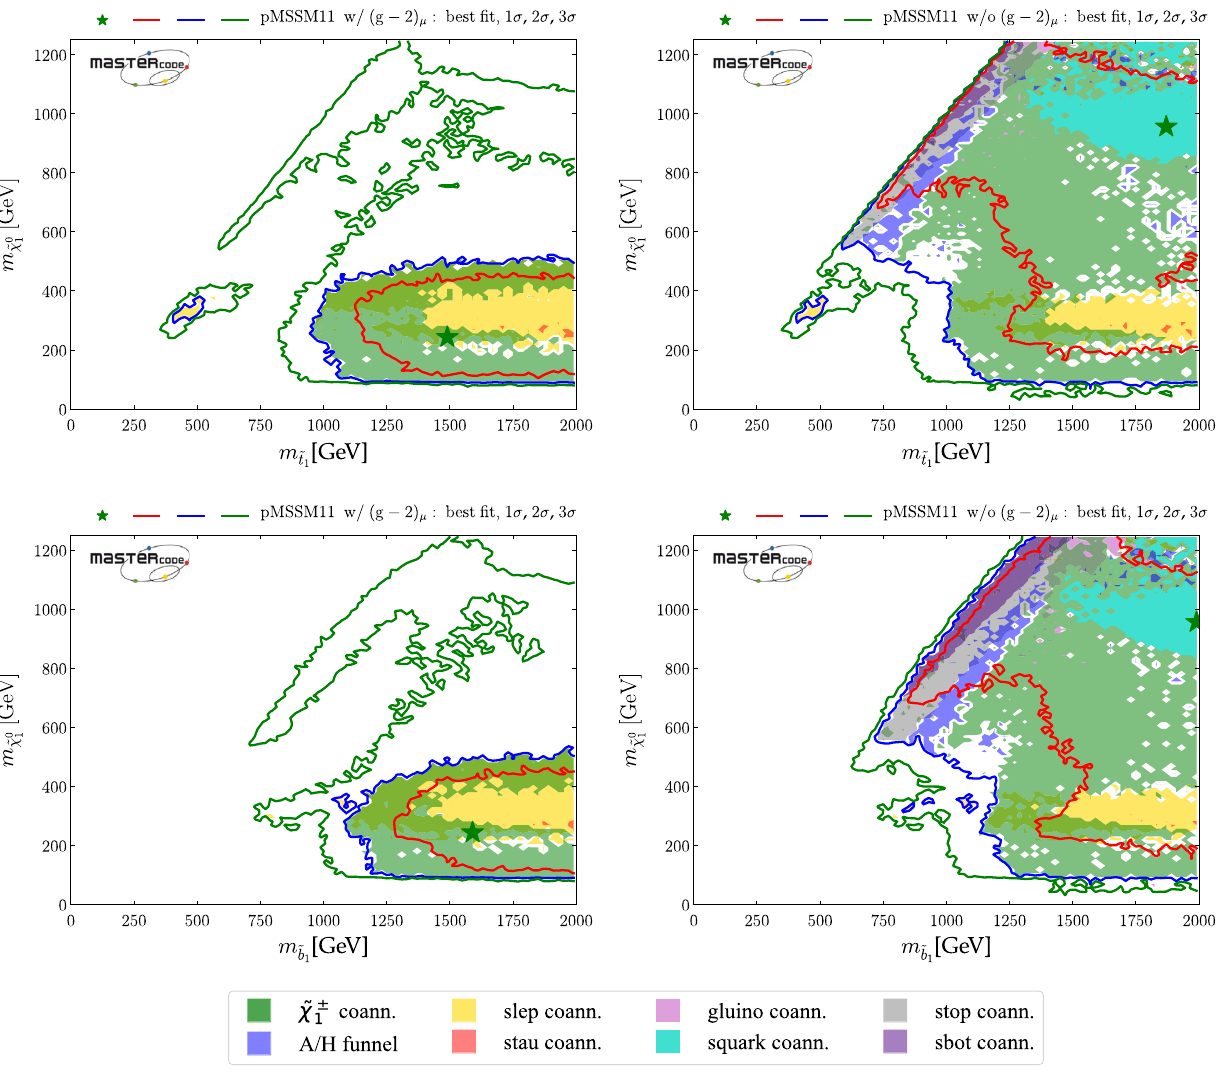
, m ) planes (upper panels) and the ( m ˜ ˜ χ 0 1 1